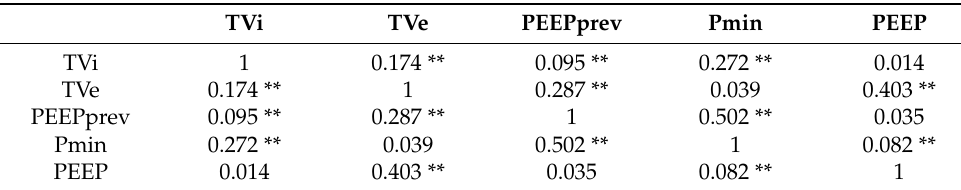
Table 5. Pearson